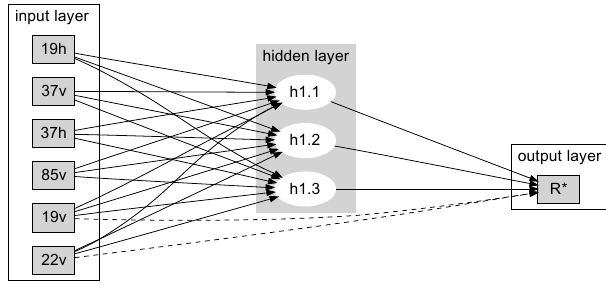
Figure 12. Neural network architecture of the precipitation re- trieval algorithm. Table 4. Accuracies of the neural net algorithm for precipitation. N = number of samples; mean, bias, and RMS are in mm / h (see